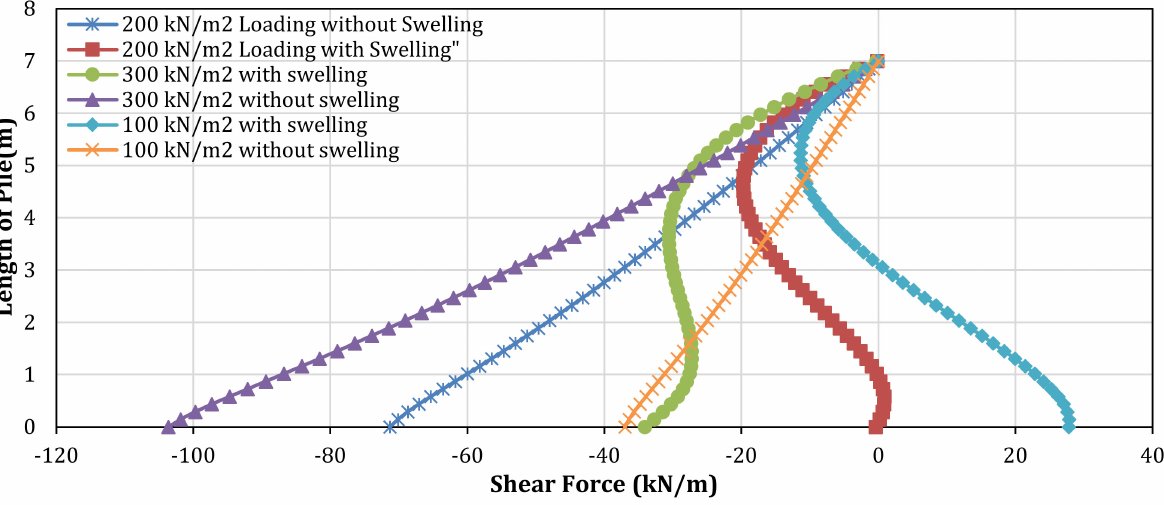
Figure 21. Shear force variation on